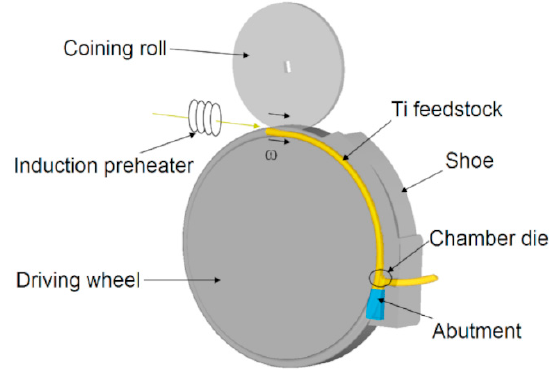
Figure 1. Schematic representation of the Conform SPD technique [24].